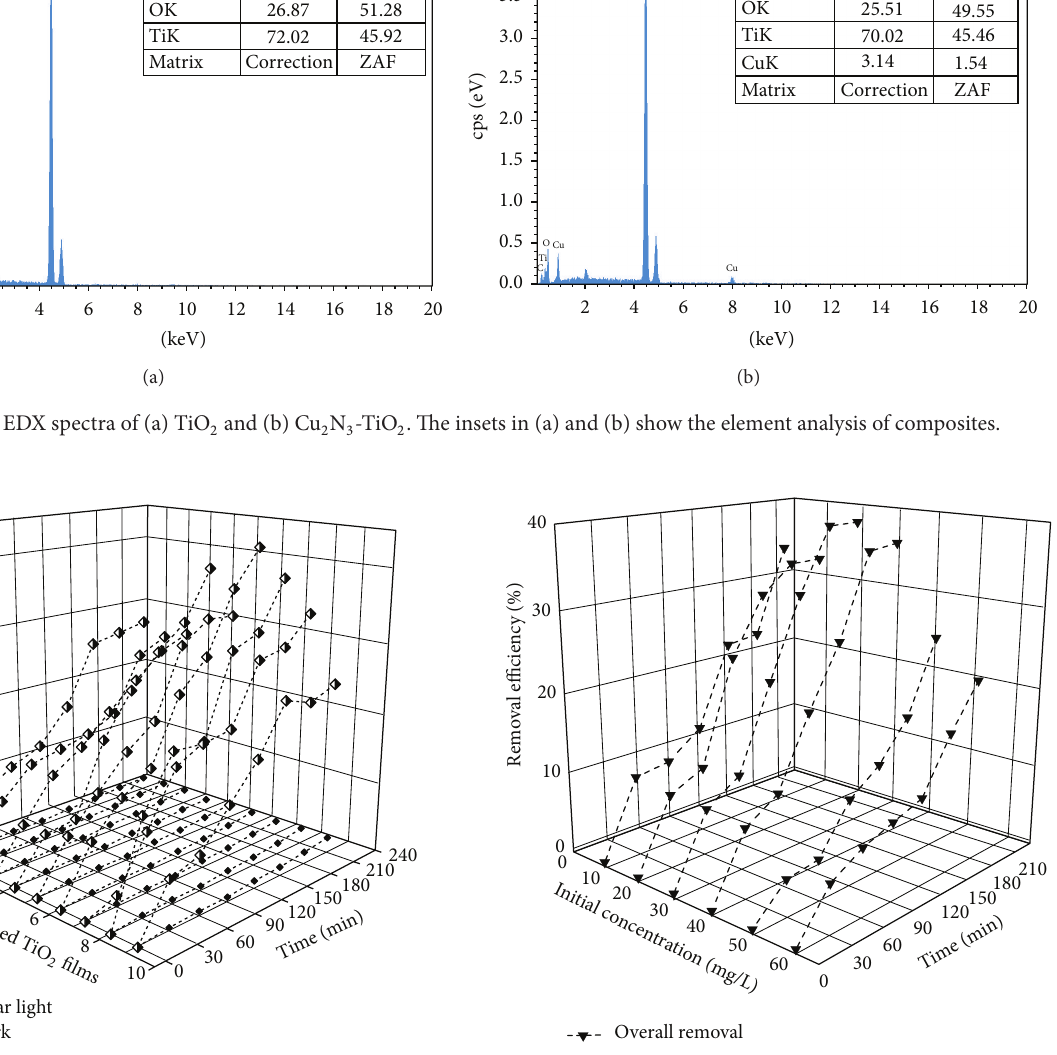
Figure 7: Degradation of humic acid under solar light and dark reaction over all Cu/N codoped TiO 2 : (1) 1: 1-500, (2) 1 :2-500, (3) 1: 3-500, (4) 2 :1-500, (5) 2 :2-500, (6) 2: 3-500, (7) 3 : 1-500, (8) 3: 2- 500, and (9) 3 :3-500.